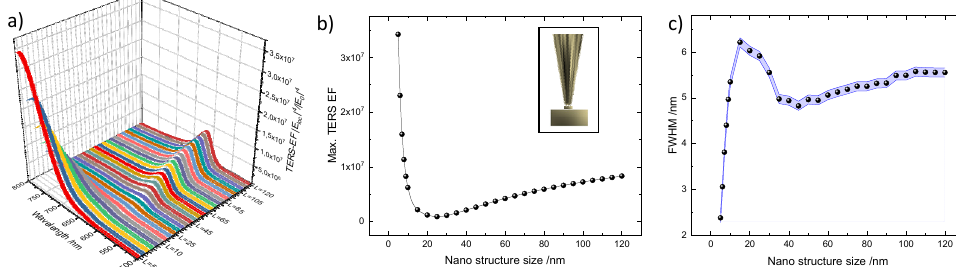
Figure 3. Simulation results when the tip is placed at the center of a nanodisc. ( a ) Spectral dependence of TERS EF, ( b ) maximum TERS EF, and ( c ) FWHM of the TERS EF profile. The blue shaded area presents the error bar of the FWHM. The tip-substrate geometry is shown in the inset of Figure 3b.